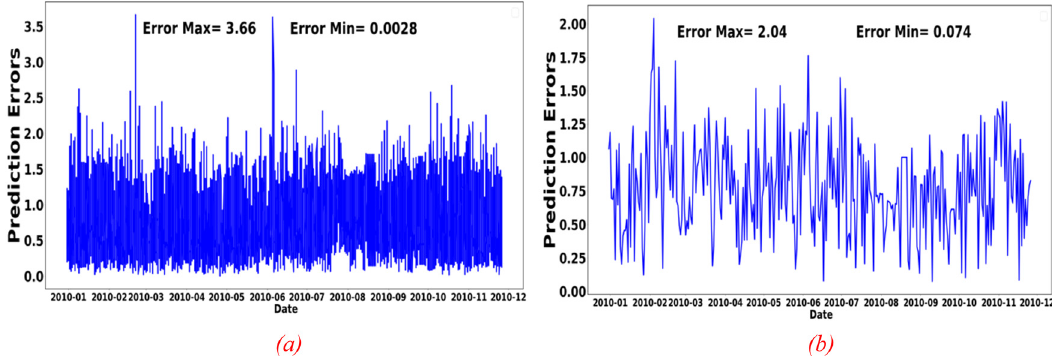
Figure 10: Household prediction errors of the XGBoost model: ( a ) hourly granularity and ( b ) daily granularity.